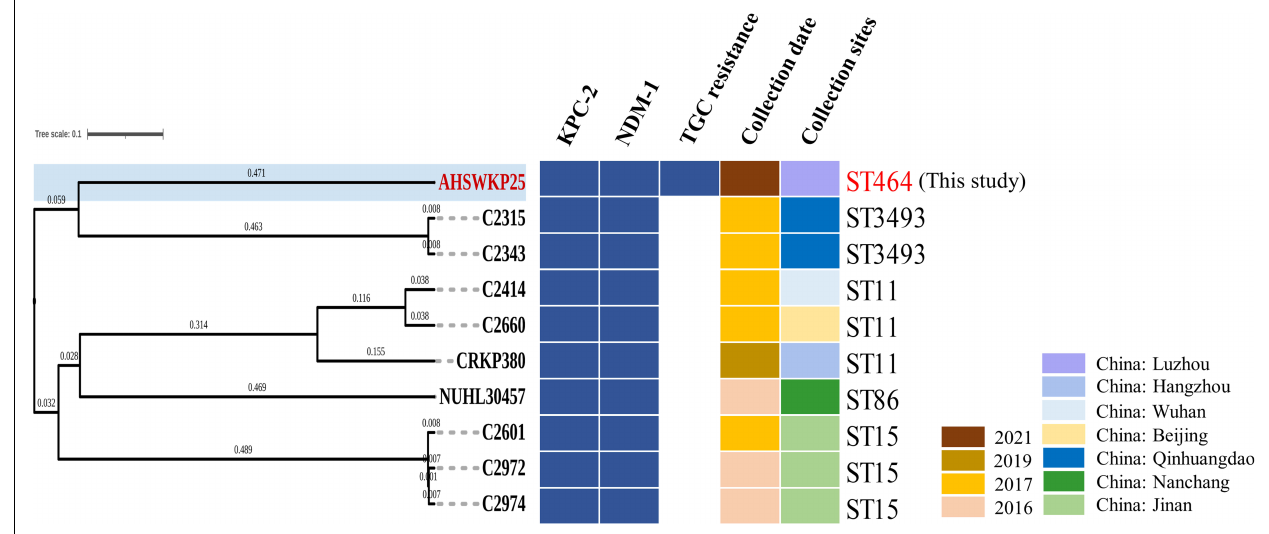
FIGURE 2 | OrthoANI-based phylogenetic tree of AHSWKP25 and other 9 NDM-1 and KPC-2 co-producing K. pneumoniae strains previously isolated from other parts of China. The different colors, respectively represented the resistance genes, collection date, and sites, blanks represent strains that are susceptible to